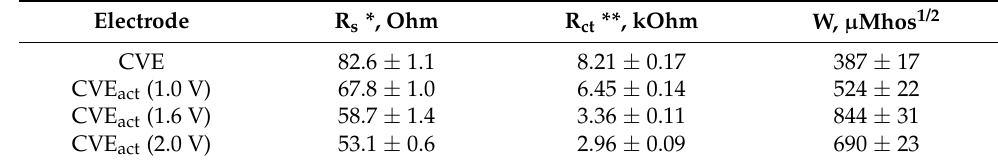
Table 2. Fitted EIS parameters using a Randles equivalent cell ( n = 3; p = 0.95).